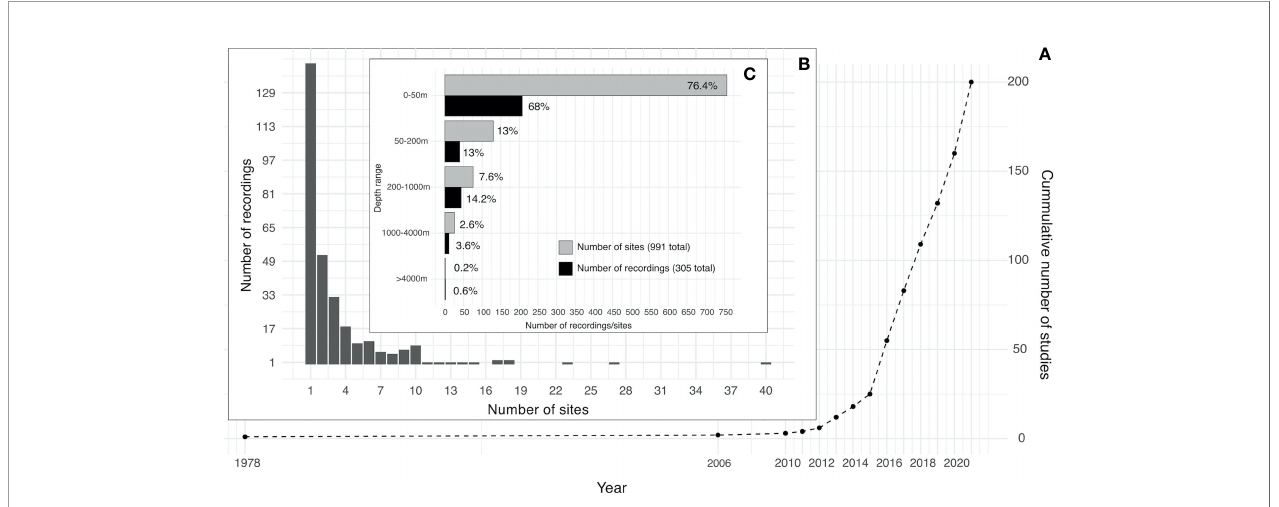
FIGURE 2 | (A) Cumulative number of studies published on ocean soundscapes through time (see Supplementary Material for data sources). (B) Number of recordings extracted from all the studies versus their number of sites. (C) Number of recordings and their sites in different depth ranges.